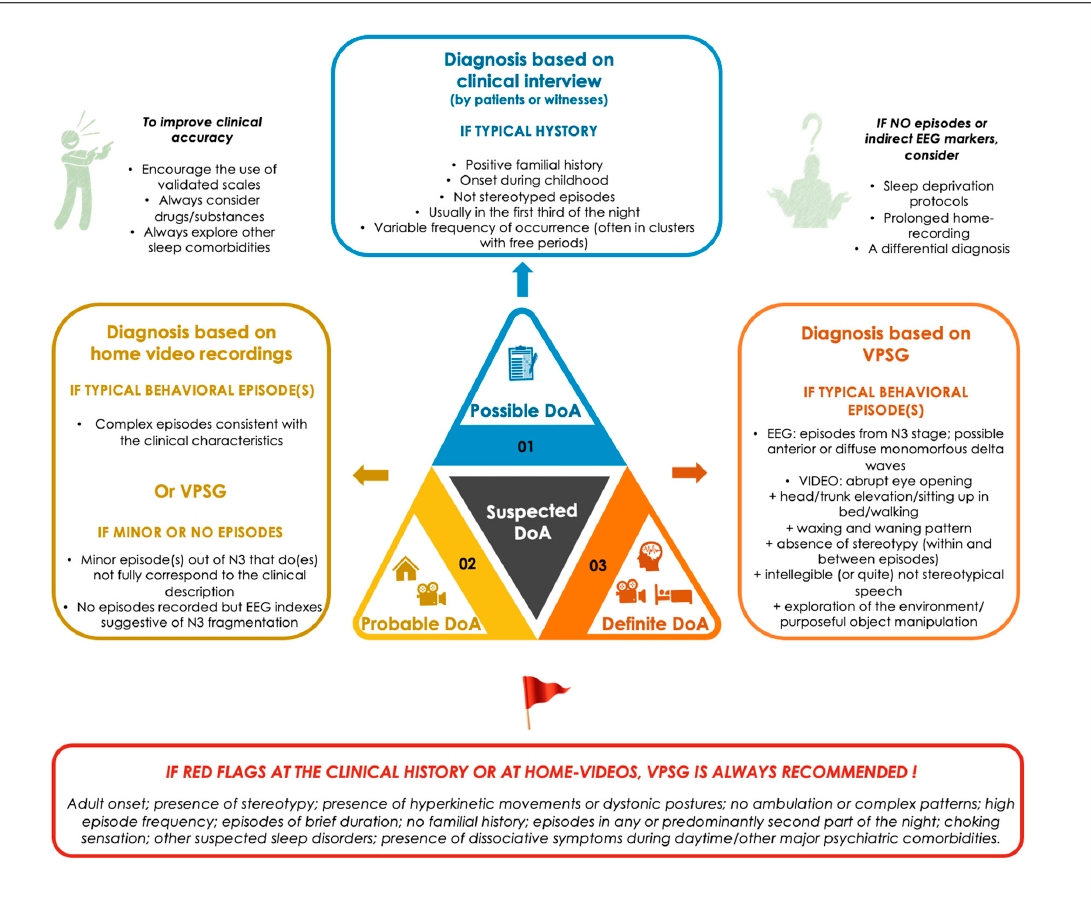
Figure 1. Proposed levels of certainty in DoA diagnosis.